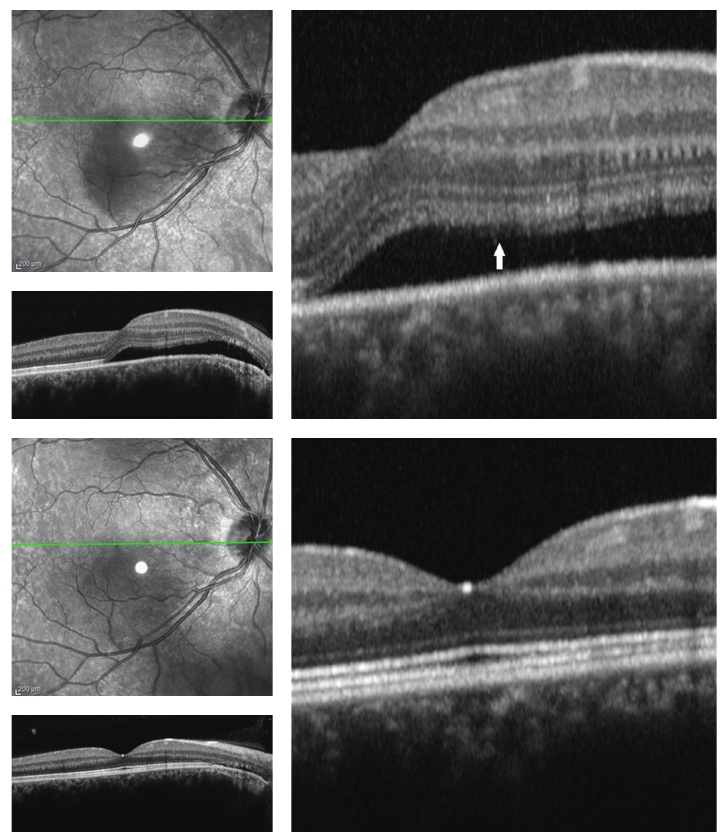
Figure 1: (Top) Acute central serous chorioretinopathy (CSC) before laser treatment. (Top right) Spectral optical coherence tomography (SD- OCT) shows elongation of the photoreceptors layer: distance before external limiting membrane (ELM) and most protruding outer segment of photoreceptors (white arrow); the RPE was flat. (Bottom) 12 months after laser treatment. (Bottom right) SD-OCT shows well-visible normal-thickness photoreceptor layer without any